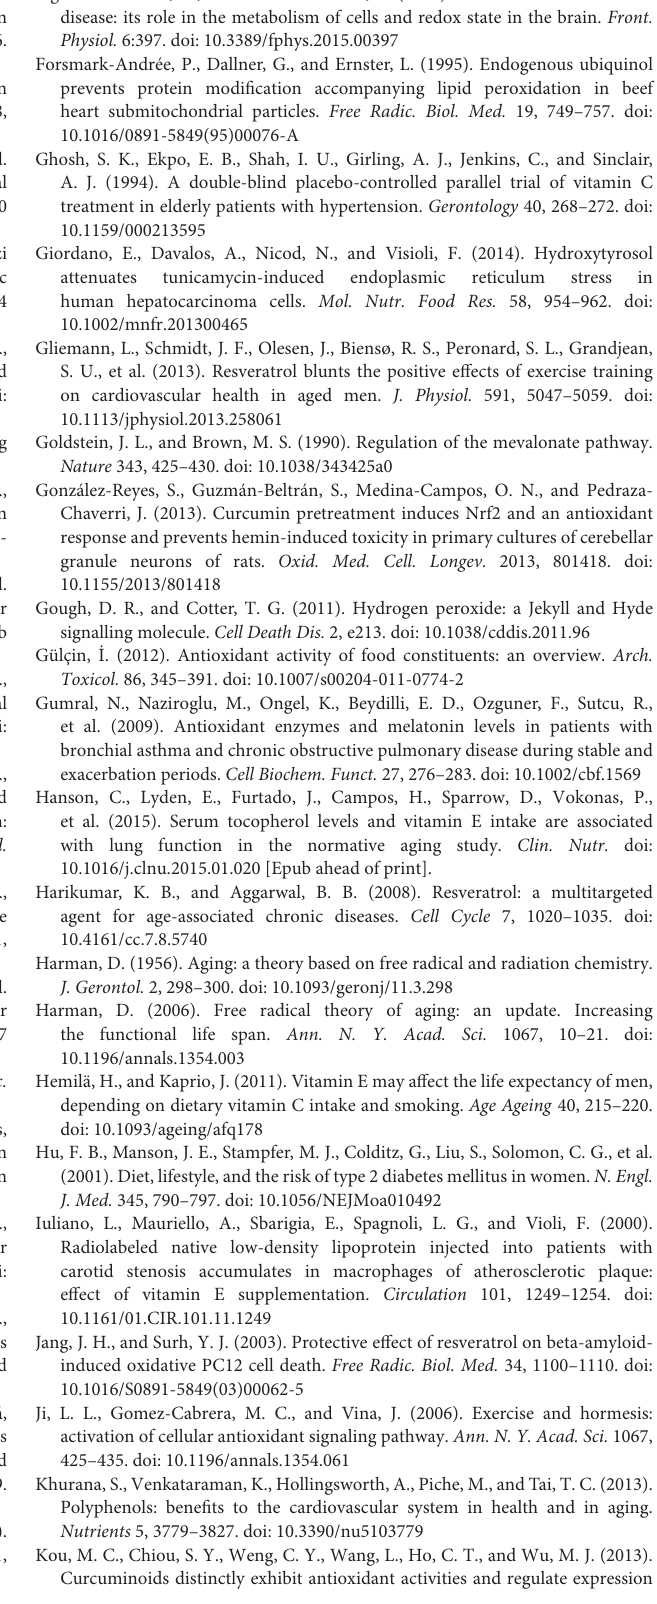
Figueroa-Mendez, R., and Rivas-Arancibia, S. (2015). Vitamin C in health and disease: its role in the metabolism of cells and redox state in the brain.